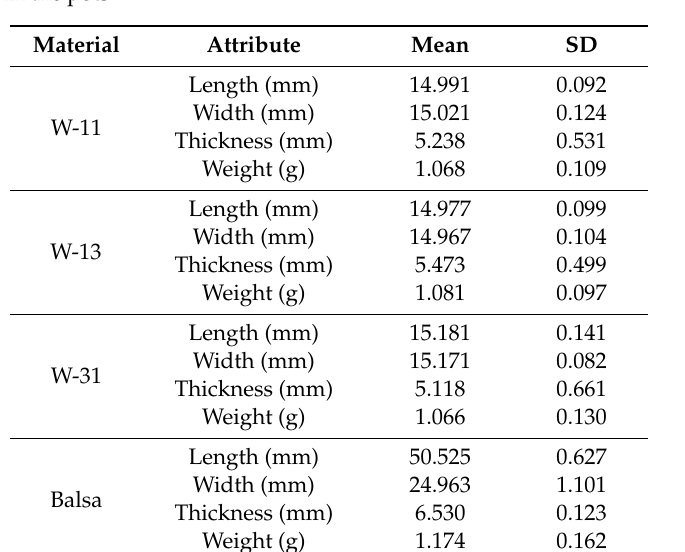
Table 2. Mean and standard deviation of material attributes (length, width, thickness, and weight) before placement in the pots.